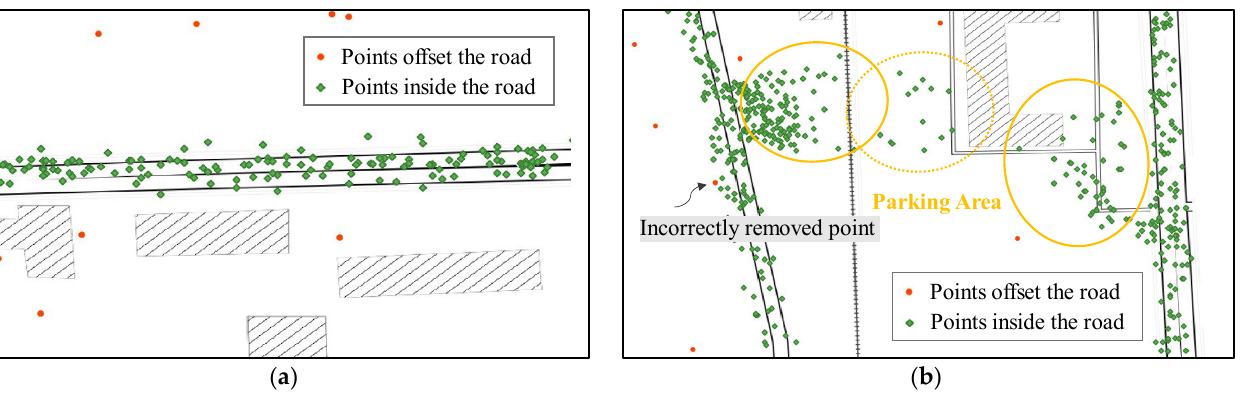
Figure 9. Example of location offset point detection. ( a ) example of well detected offset points. ( b ) example of trajectory points in a parking area.